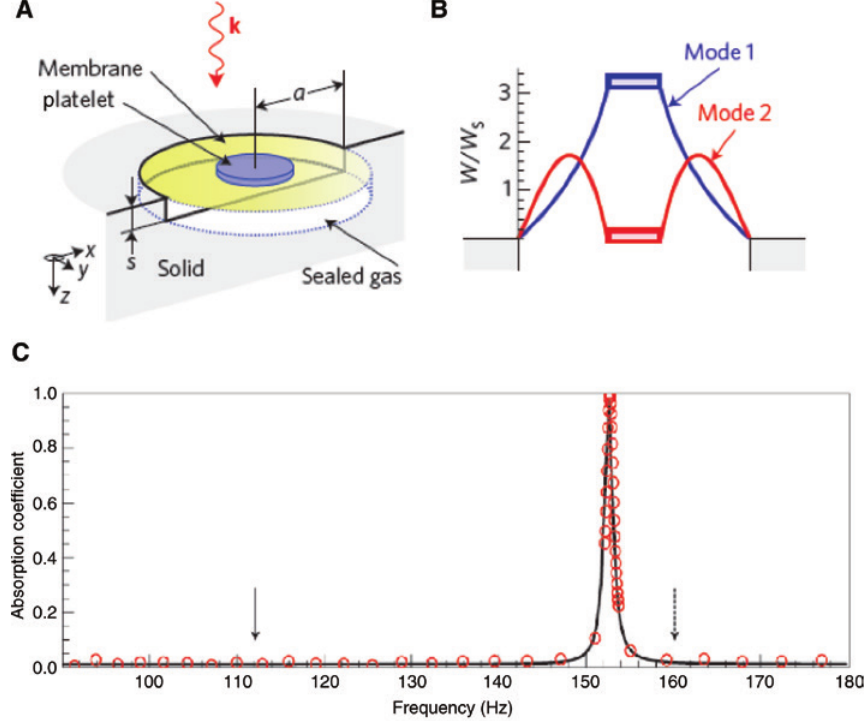
Figure 12: Acoustic metasurface with hybrid interfaces. (A) Schematic illustration of the unit cell’s components and geometry. (B) Schematic cross-sectional illustration of the two lowest frequency eigenmodes. (C) Measured absorption coefficient as a function of frequency. The solid and dashed arrows indicate the first eigenmode and anti-resonance (reprinted from Ref.